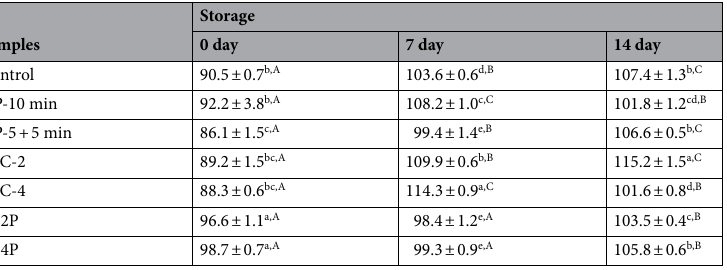
Table 2. Conjugated diene content (μmol/100 g) of brown rice processed with different treatments during storage. Values are means ± standard deviations (n = 3). Within columns, means followed by different letters are significantly different ( p < 0.05). Within rows, means followed by different capitals are significantly different ( p < 0.05).